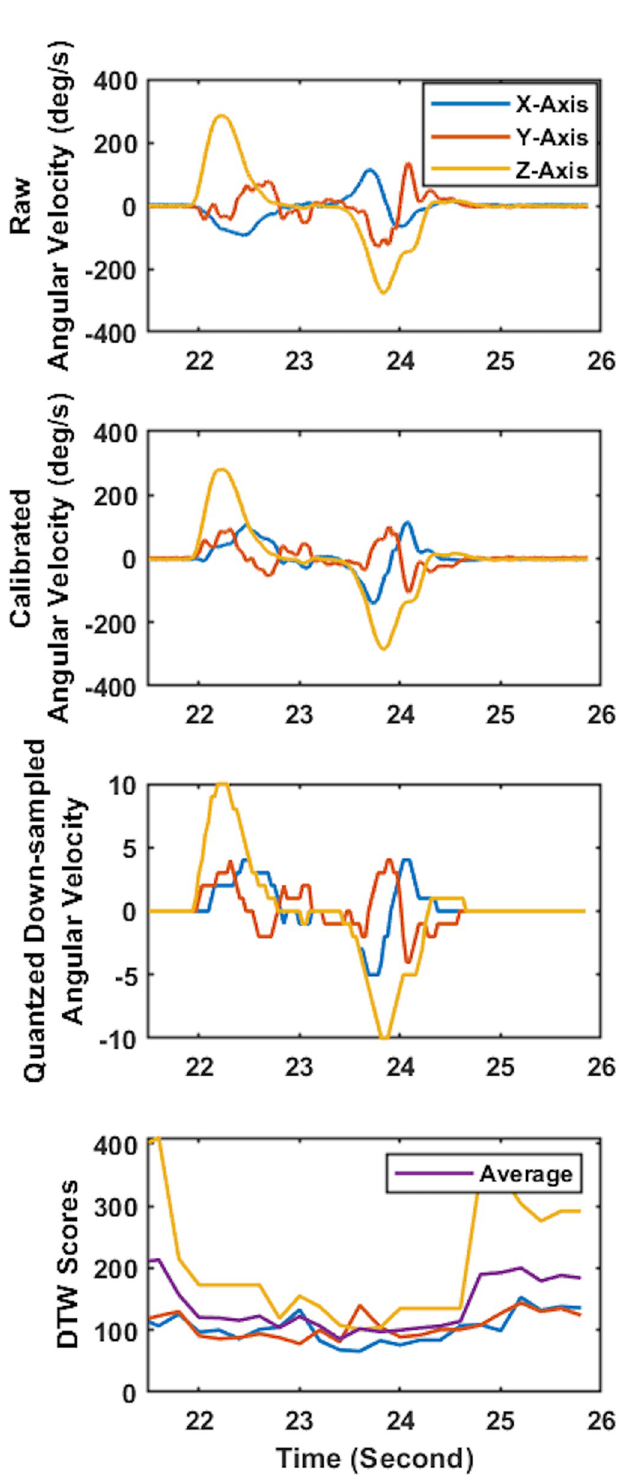
Fig 3. Sample 3D angular velocity time-series and associated DTW scores. a) Raw 3D angular velocity time-series during a face touch, b) angular velocity time-series after vertical alignment, c) angular velocity time-series after down- sampling and quantization, and d) the DTW scores calculated comparing the pattern of quantized down-sampled angular velocity time-series to template time-series.